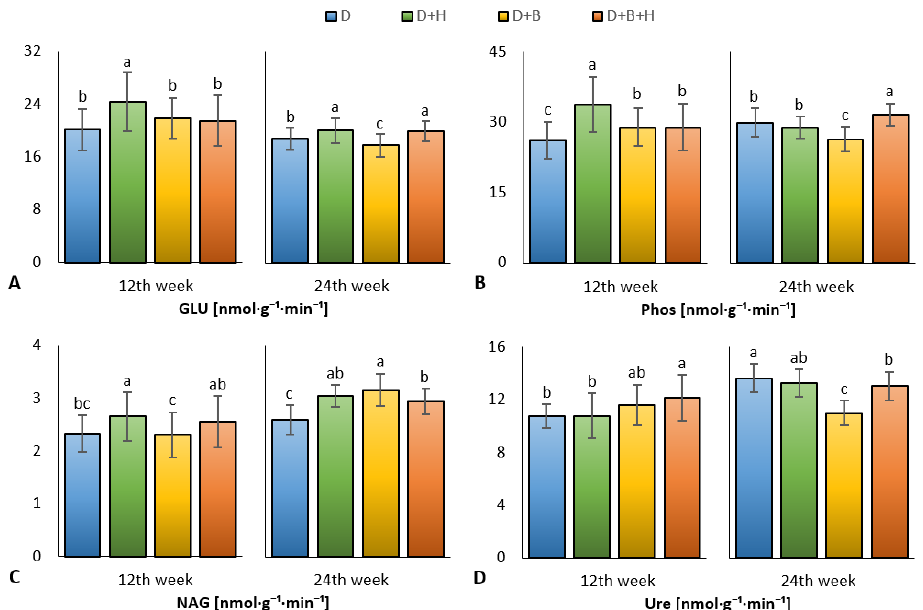
Figure 3. β -glucosidase ( A ), phosphatase ( B ), N-acetyl- β -D-glucosaminidase ( C ), and urease ( D ) un- der experimental variants in the first and second part of pot experiment. Different letters indicate statistically significant differences of Tukey HSD post-hoc test at p ≤ 0